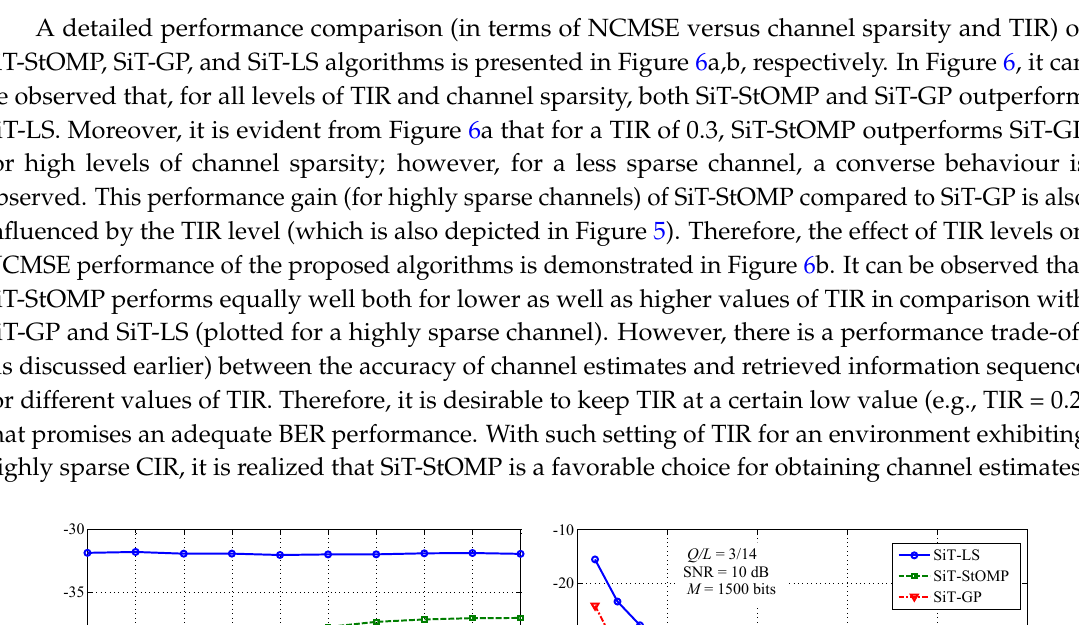
Figure 5. Effect of training-to-information ratio (TIR) variation on NCMSE performance of proposed methods, M = 1500 bits, and Q / L = 3/14, ( a ) SiT-StOMP; ( b ) SiT-GP.